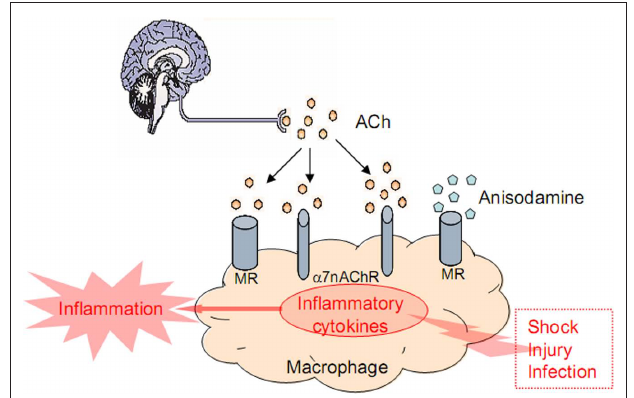
FiguRe 1 | The Chinese medicinal herb Scopolia tangutica Maxim .